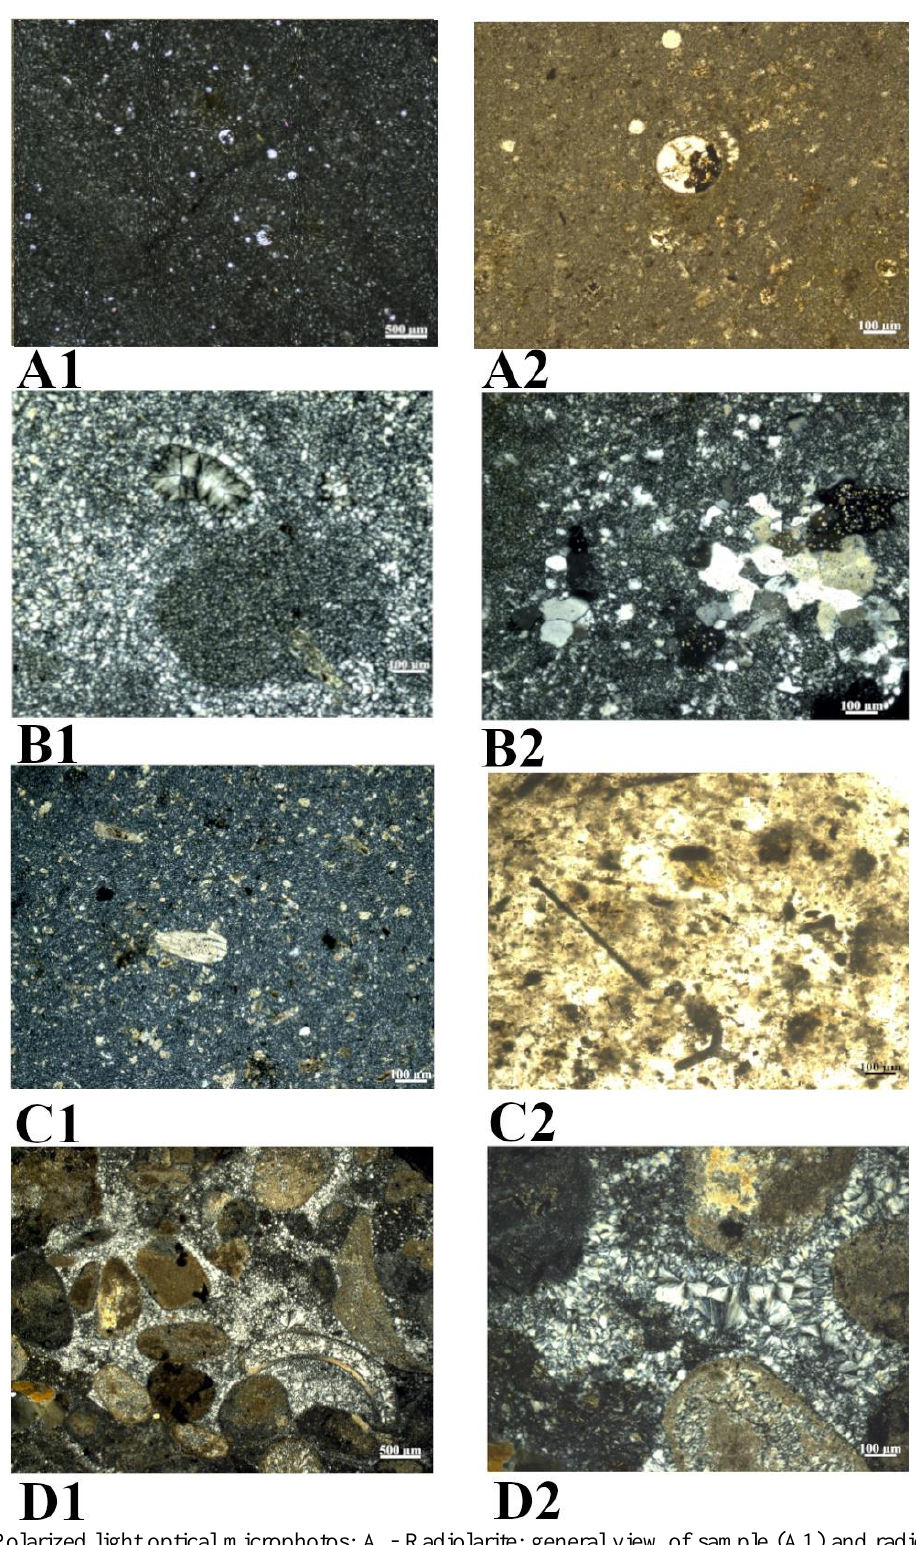
Figure 4. Polarized light optical microphotos: A - Radiolarite: general view of sample (A1) and radiolarian test in detail (A2); B - Chert: microfossil replaced by chalcedony that grades inward into megaquartz (B1) and a cavity filled by a mosaic of megaquartz (B2); C - Fossiliferous chert: a shell fragment in a fine-grained mass of microquartz (C1) and monaxon and triaxon sponge spicules in chert (C2); D - Siliceous limestone ( Grainstone ) with ooliths in siliceous cement made of microquartz (D1) and fibrous microquartz filling spaces among clasts (D2). All images with crossed polarizers, except A1 and C2 (one polarizer). Images A1, B1, C1, and D1 are from Rey-Solé et al.